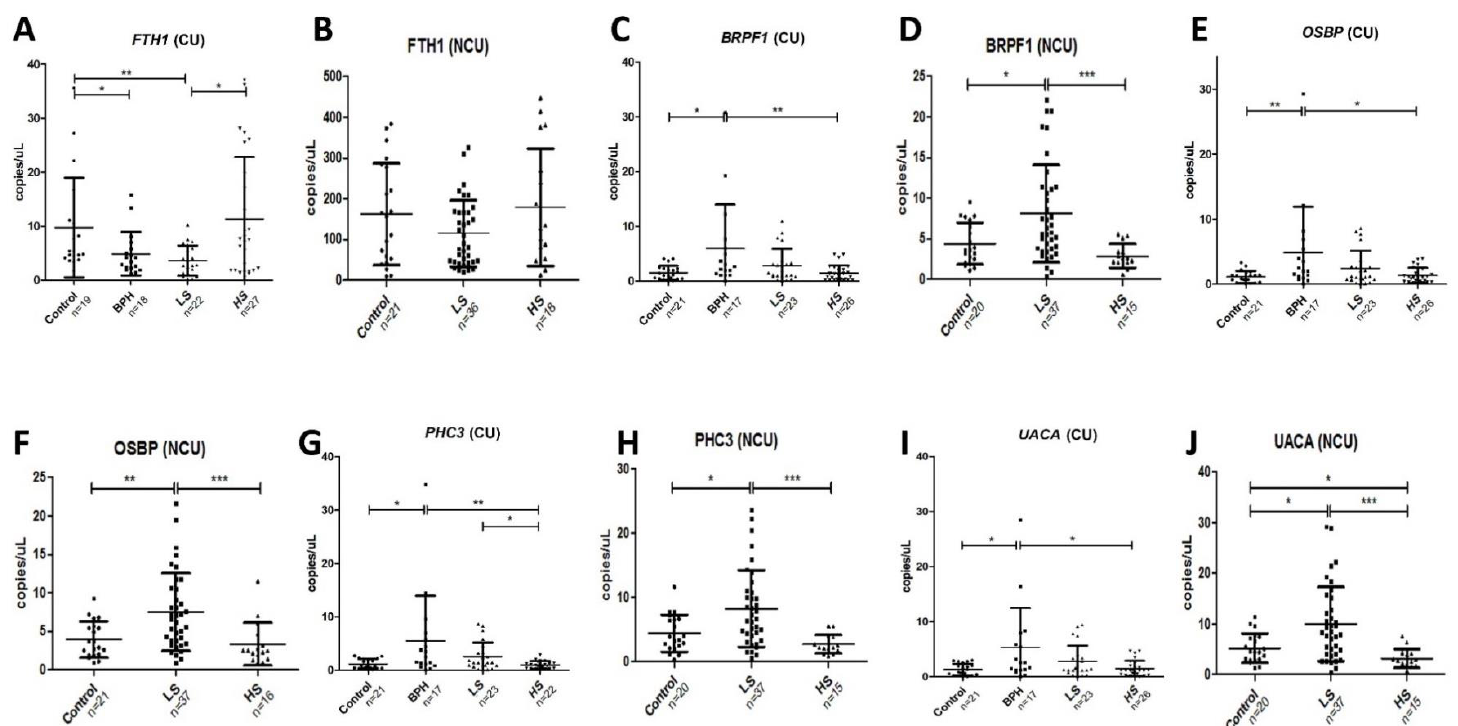
Figure 2. Expression levels of mRNA (copies/ μ L) measured by droplet digital (dd)PCR in independent validation cohorts of CU and NCU samples. Expression levels were compared using Mann–Whitney independent t-test (* p ≤ 0.05; ** p ≤ 0.01; *** p ≤ 0.001). LS, low stage (stage I and II); HS, high stage (stage III and IV). (A) Levels of FTH1 in CU samples. (B) Levels of FTH1 in NCU samples (C) Levels of BRPF1 in CU samples (D) Levels of BRPF1 in NCU samples (E) Levels of OSBP in CU samples (F) Levels of OSBP in NCU samples. (G) Levels of PHC3 in CU samples. (H) Levels of PHC3 in NCU samples. (I) Levels of UACA in CU samples. (J) Levels of UACA in NCU samples. Table 2. ROC analysis of selected mRNA biomarkers. * Reference samples used as controls for ROC analysis. †Composition of panel genes given in parenthesis. Probe